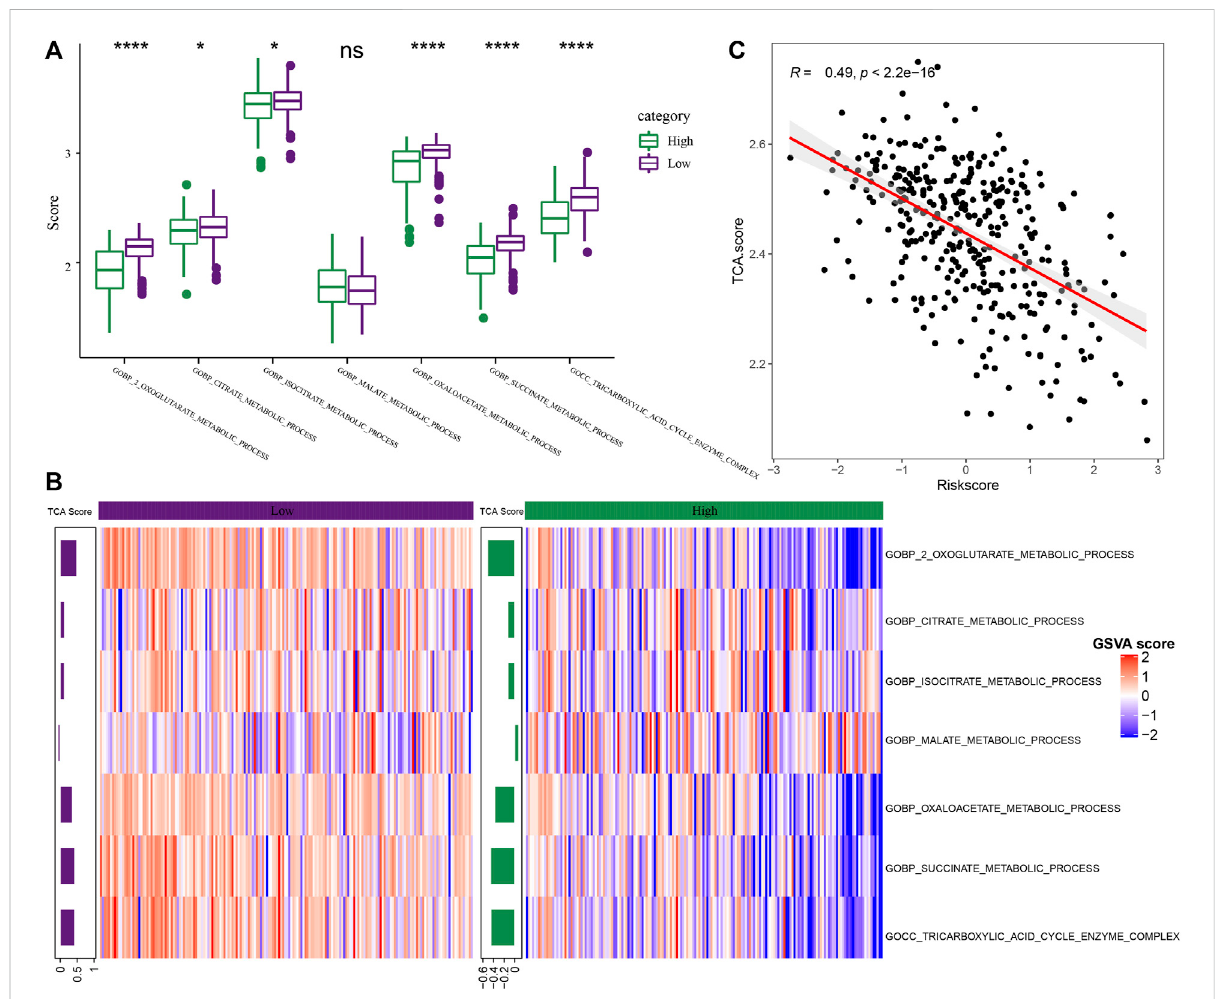
FIGURE 9 Differences in pathway characteristics among different RS groups. (A) The box plot of TCA-related pathway scores in high-risk and low-risk groups in the TCGA dataset (Wilcox.test, * p < 0.05; ** p < 0.01; *** p < 0.001; and **** p < 0.0001); (B) The heat map of TCA related pathway scores in the high-risk and low-risk groups in the TCGA-LIHC dataset; (C) The scatter diagram of correlation analysis between RS and TCA scores in TCGA- LIHC